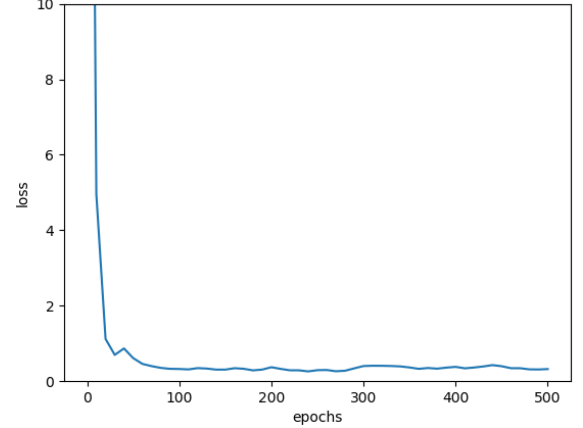
= · · · = π = 0.01 ( right , without 1 100